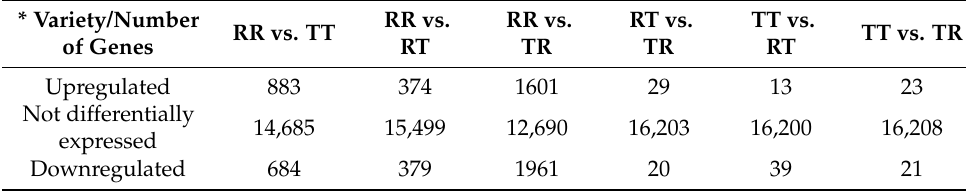
Table 1. Number of differentially expressed genes between pig